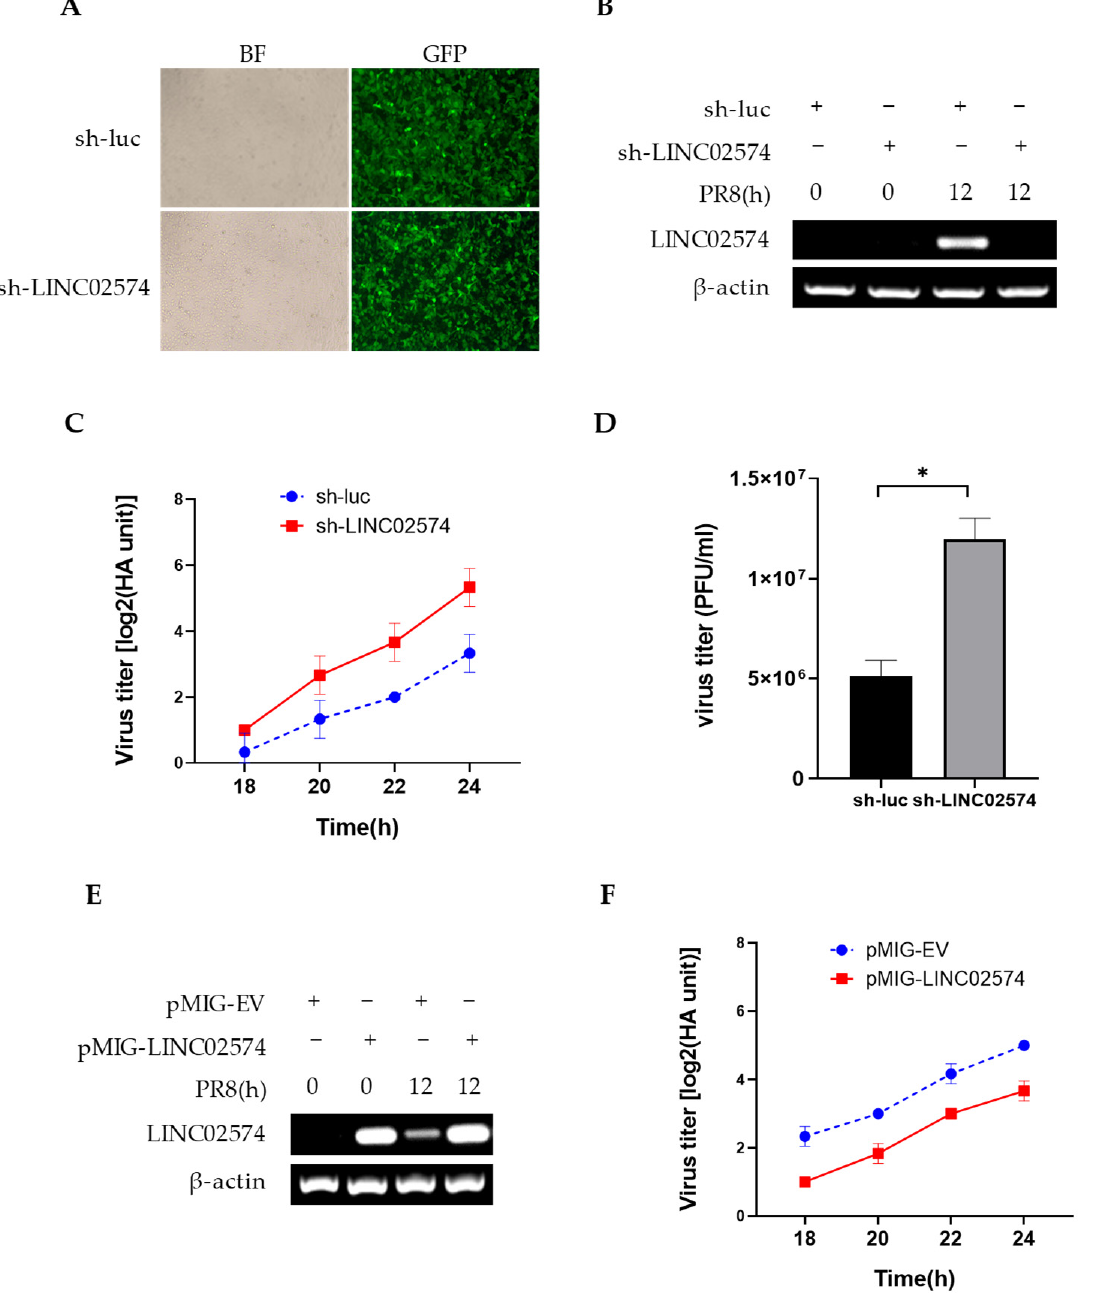
Figure 5. LINC02574 inhibits the replication of IAV. ( A ) Shown are A549 cell lines stably expressing shRNAs targeting LINC02574 (sh-LINC02574) or luciferase control (sh-luc). ( B – D ) A549 cells stably expressing specific shRNAs targeting LINC02574 or luciferase control were infected with PR8 virus for 24 h. Total RNA was then extracted for RT-PCR to detect the expression of LINC02574 ( B ). The cell culture supernatants were harvested at the indicated times for hemagglutinin assay ( C ) and at 20 h for plaque-forming assay ( D ) to measure virus titers. ( E , F ) A549 cells carrying either LINC02574- expressing plasmid (pMIG-LINC02574) or empty vector (pMIG-EV) were infected with or without PR8 virus for 24 h. After infection, total RNA was extracted for RT-PCR to detect LINC02574 expression ( E ). The cell culture supernatants were harvested at the indicated times for hemagglutinin assay ( F ). Data are represented as mean ± SD; n = 3; * p < 0.05, Student’s t